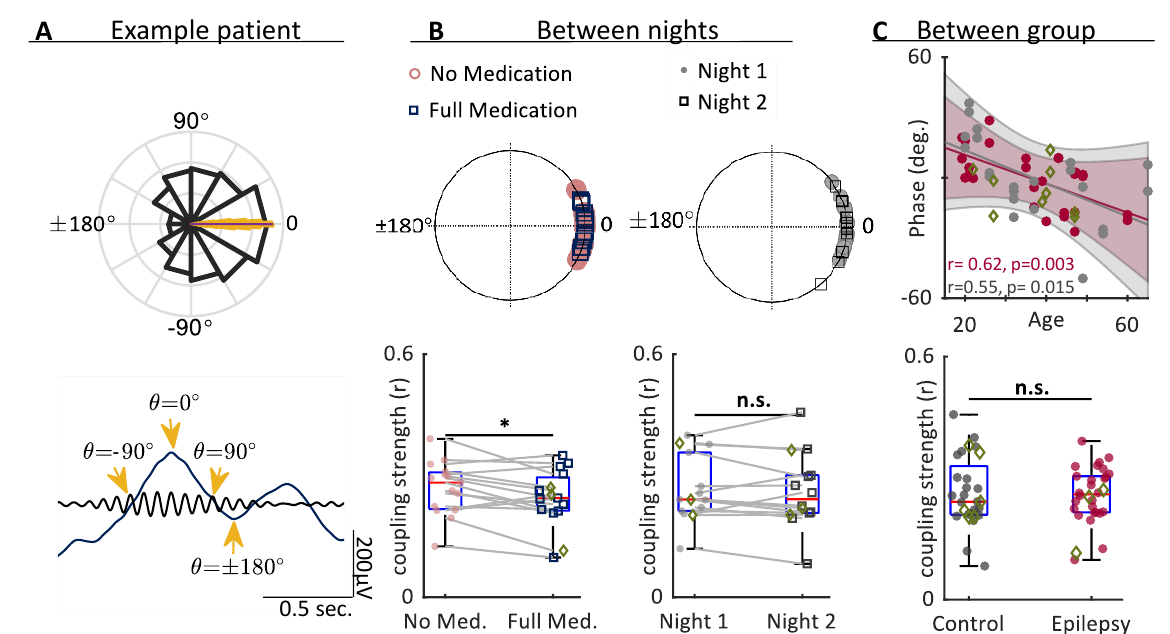
Figure 5. ASM medication reduces spindle-slow wave coupling. ( A ) Example data from a patient in the Epilepsy group. Upper panel is a normalized histogram of the slow wave phases that coincided with spindle peaks (black). Data were non-normally distributed ( p < 0.001, z = 65.6, Rayleigh test, resultant vector length r = 0.22). Overlaid yellow bar shows the bootstrapped mean (10,000 iterations, p < 0.001, Watson-Williams parametric test of equal means). Lower plot shows a single filtered spindle (black) and slow wave (blue) with the phase of the slow wave labelled (orange arrows). ( B ) (upper circular plots) Each point represents the mean coupling phase for a single night of data, with values calculated as in part A. Both groups show tight coupling to the peak of the slow wave. Nights without medication are in pink, nights with medication are in blue. (lower plots) Coupling strength, as determined by the vector length, r, was significantly reduced with ASMs ( p = 0.028, paired t -test), but was unaffected between nights in the Control group ( p = 0.61). ( C ) The phase of coupling correlated with age in both epilepsy ( p = 0.003, correlation coefficient 0.62) and control ( p = 0.015, correlation coefficient = 0.55) groups (circular-linear correlation). A two-way circular-linear ANOVA, binning ages by decade, found that age had a significant effect on coupling phase (F(4) = 9.9, p < 0.001), but there was no main effect of diagnosis (F(1) = 0.24, p = 0.63), but diagnosis did interact with age (F(4) = 5.9, p = 0.0006) (below). The two groups did not differ in the strength of phase coupling (on either night, p > 0.05, unpaired t -test). Epilepsy group shown in pink, controls shown in grey, * p < 0.05, n.s. p > 0.05. Green diamonds show those taking Benzodiazepines.